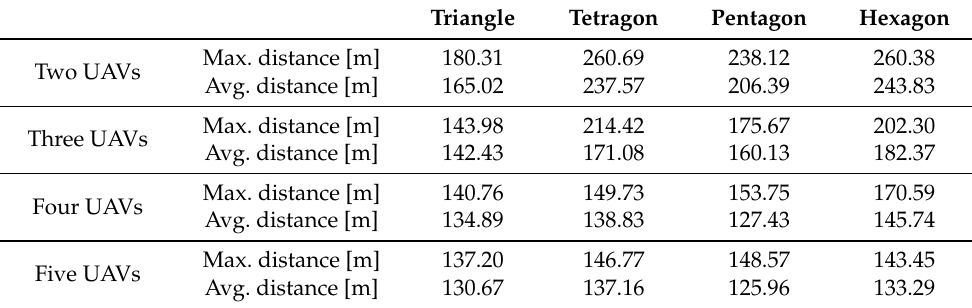
Table 2. Task assignment results for various